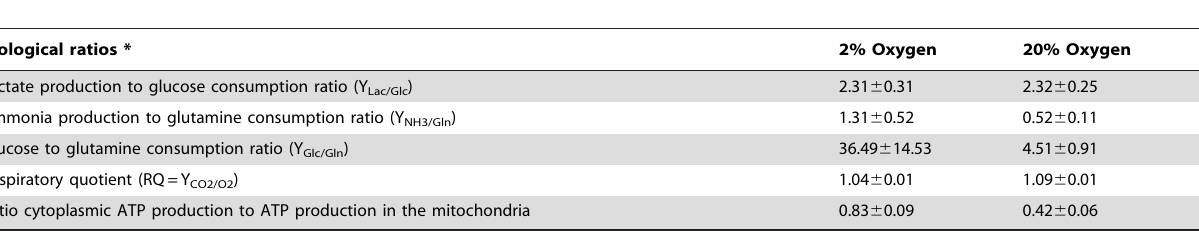
Table 2. Biological ratios of human embryonic stem cells cultured at physiological and atmospheric oxygen concentrations.